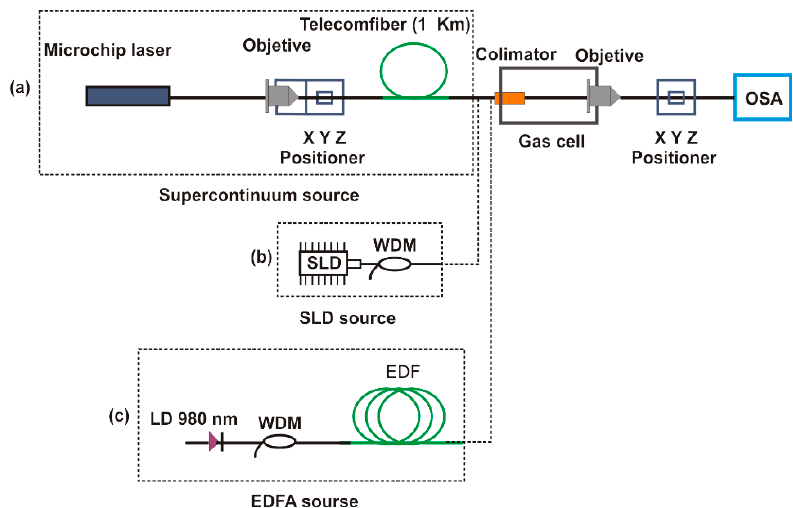
Figure 1. Experimental setup ( a ) Light from the supercontinuum (SC), ( b ) light from the Super-luminescent Diodes (SLD), ( c ) light from erbium-doped fiber amplified (EDFA). All are coupled to a fiber optic collimator. Sensors 2020 , 20 , x FOR PEER REVIEW